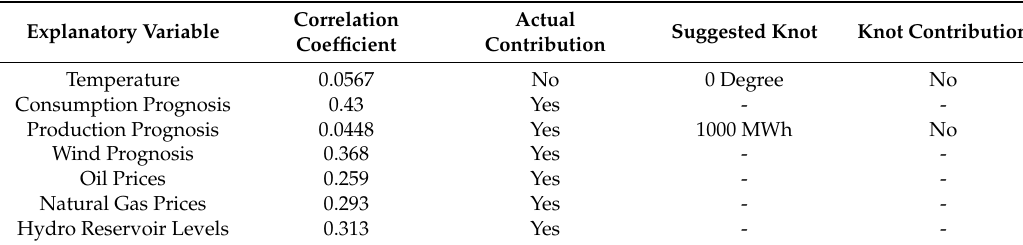
Table 1. Explanatory